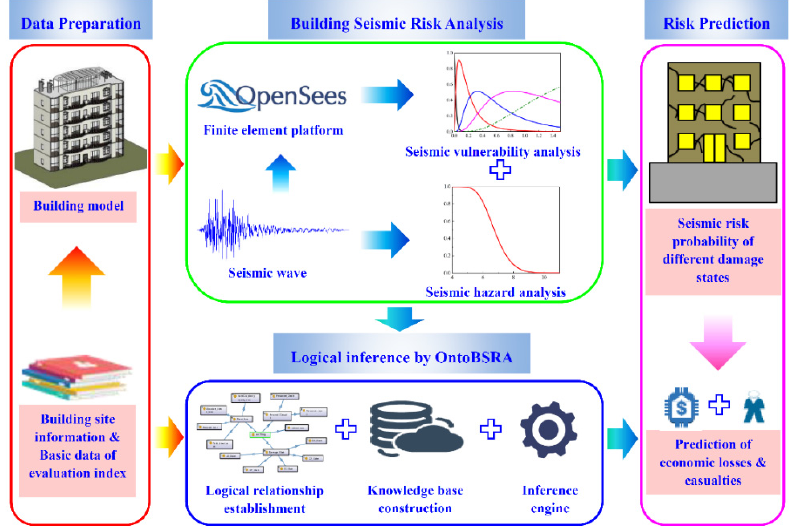
Figure 1. Seismic risk prediction framework flow chart.